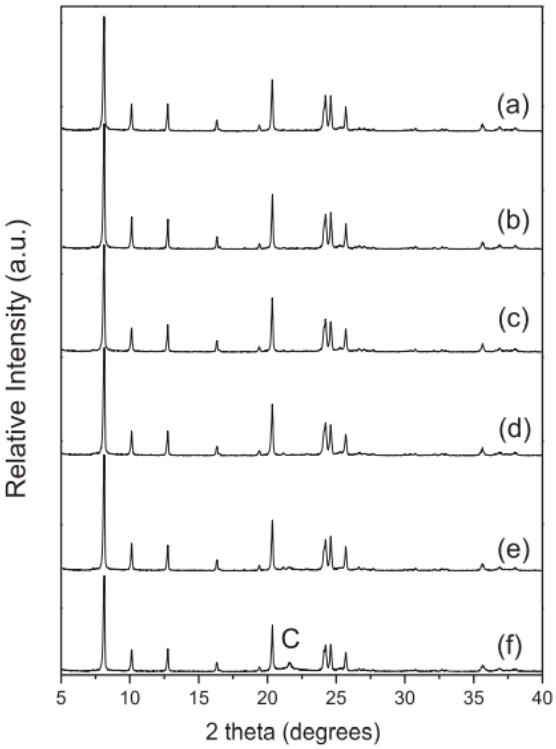
Figure 4. X-ray diffractograms of the Ti-TON zeolite prepared with reaction times of ( a ) 1 day, ( b ) 3 days, and ( c ) 7 days with stirring, and ( d ) 1 day, ( e ) 3 days, and ( f ) 7 days in static mode